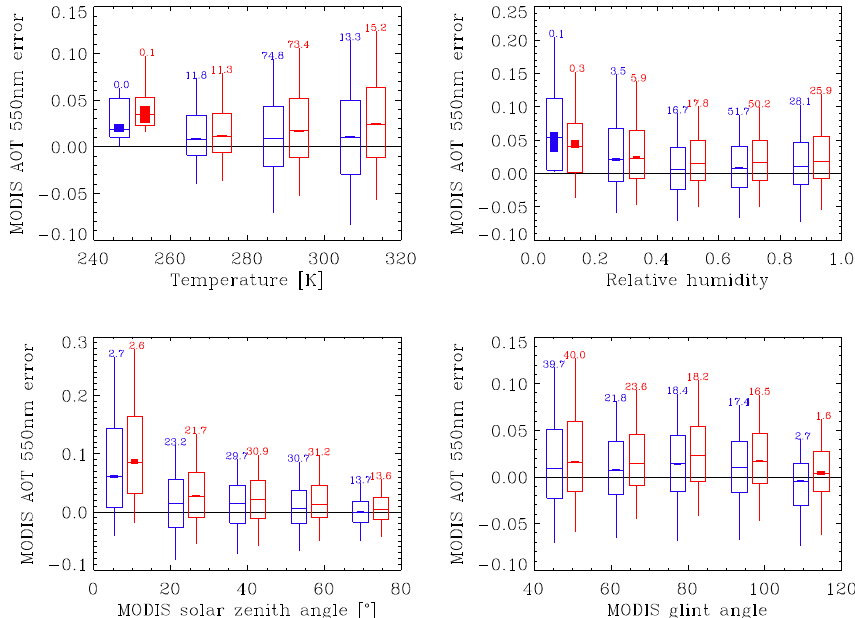
Fig. 4. MODIS AOT error statistics as a function of NCEP-DOE-II temperature (2m) or relative humidity (2m), MODIS scattering or glint angle (blue: Aqua; red: Terra). The box–whisker plots are offset from these bin centres to show the two distributions side by side. Numbers above the box and whisker show the percentage of the total sample used in that bin.